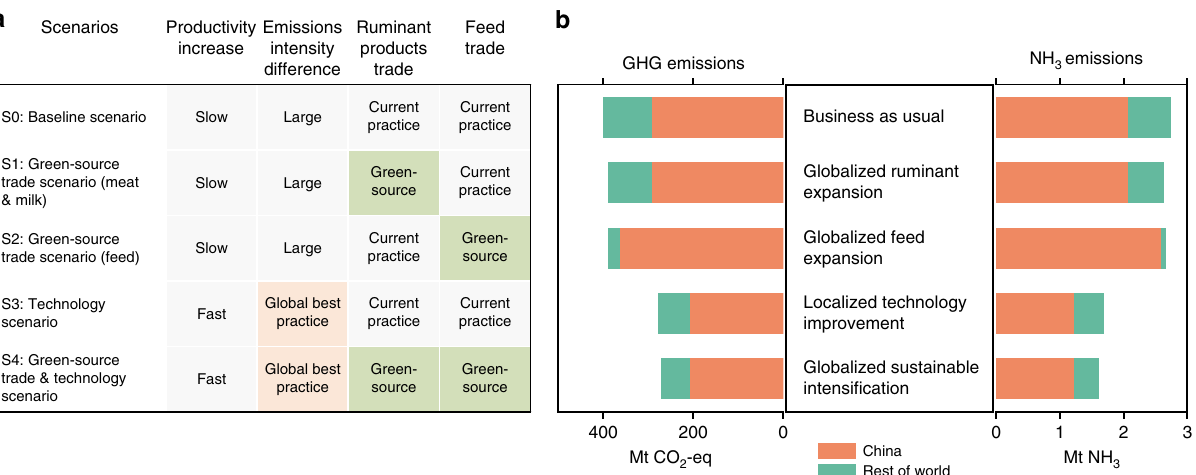
Fig. 4 Potential mitigation strategies to meet China ’ s demand for ruminant products in 2050 and the corresponding domestic and transferred contributions to global greenhouse gases and ammonia emissions. In scenarios S0 – S4, the additional demand relative to 2012 is met by either improved technology in domestic production and/or increased imports of ruminant products or feeds. Green-source trade refers to the import of ruminant products or feeds that are produced with global best-practice in emission controls. Current practice means the importing ratios and importing nations are the same as 2012. Two additional endpoint scenarios (total global supply and total domestic supply) are shown in Supplementary Fig. 5 for comparison. For details of